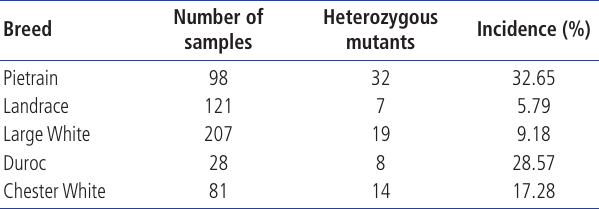
Table 3. Incidence of heterozygous mutants among different breeds